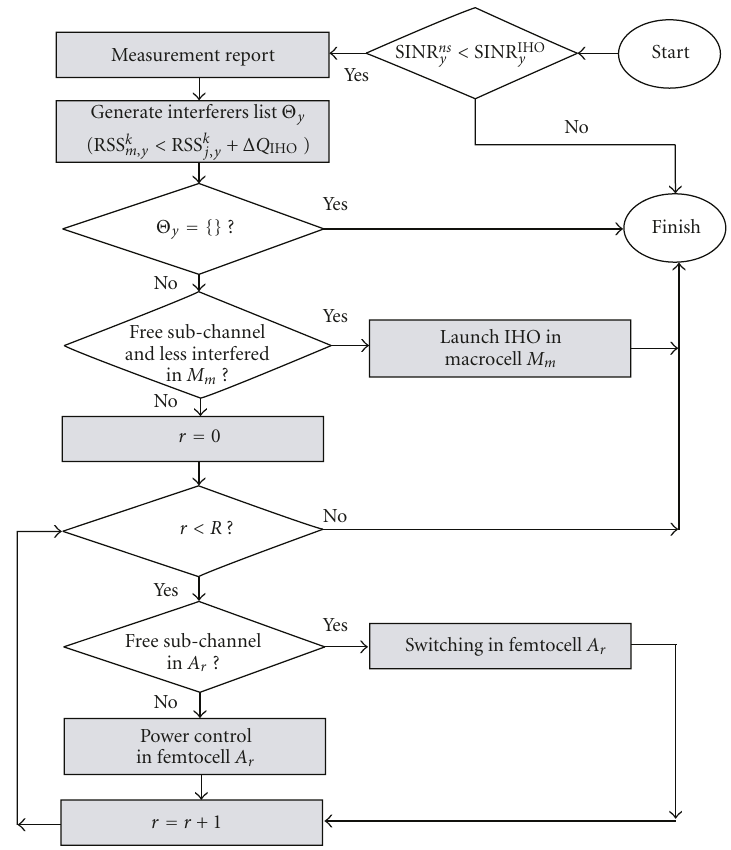
Figure 1: Intracell Handover